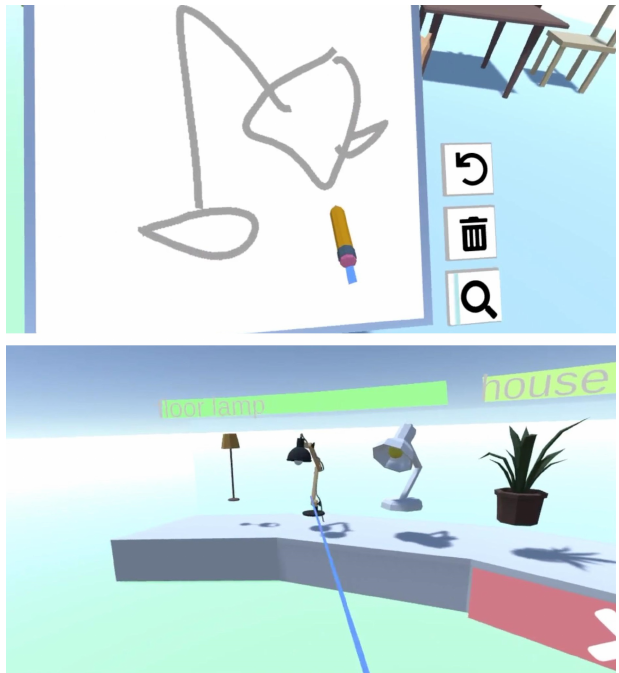
Figure 12. Top: The user draws a sketch of the lamp. Bottom: Based on the sketch the user can choose between different 3D objects.